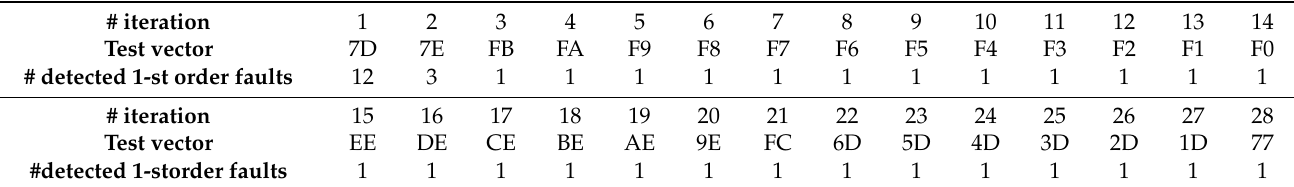
Table 3. List of the first-order